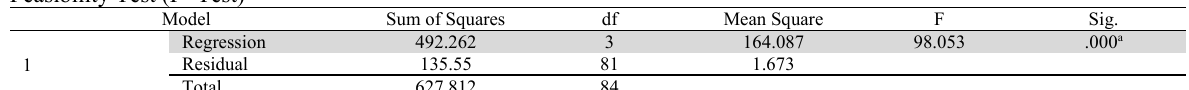
Significant Test of Individual Parameters (T-Test) Unstandardized Coefficients Standardized Model B Std. Error Beta